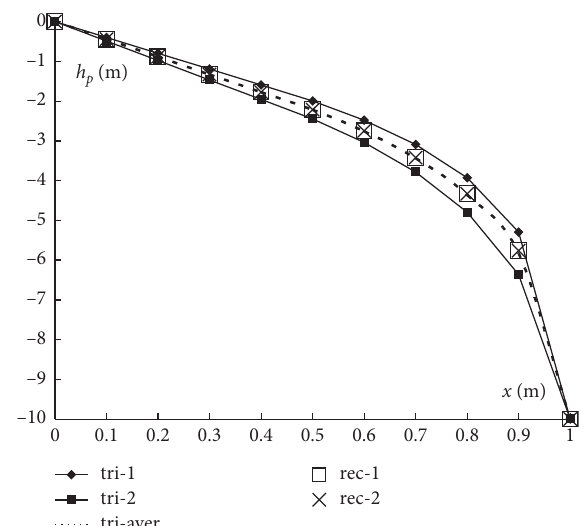
Figure 5: Hydraulic head differences with